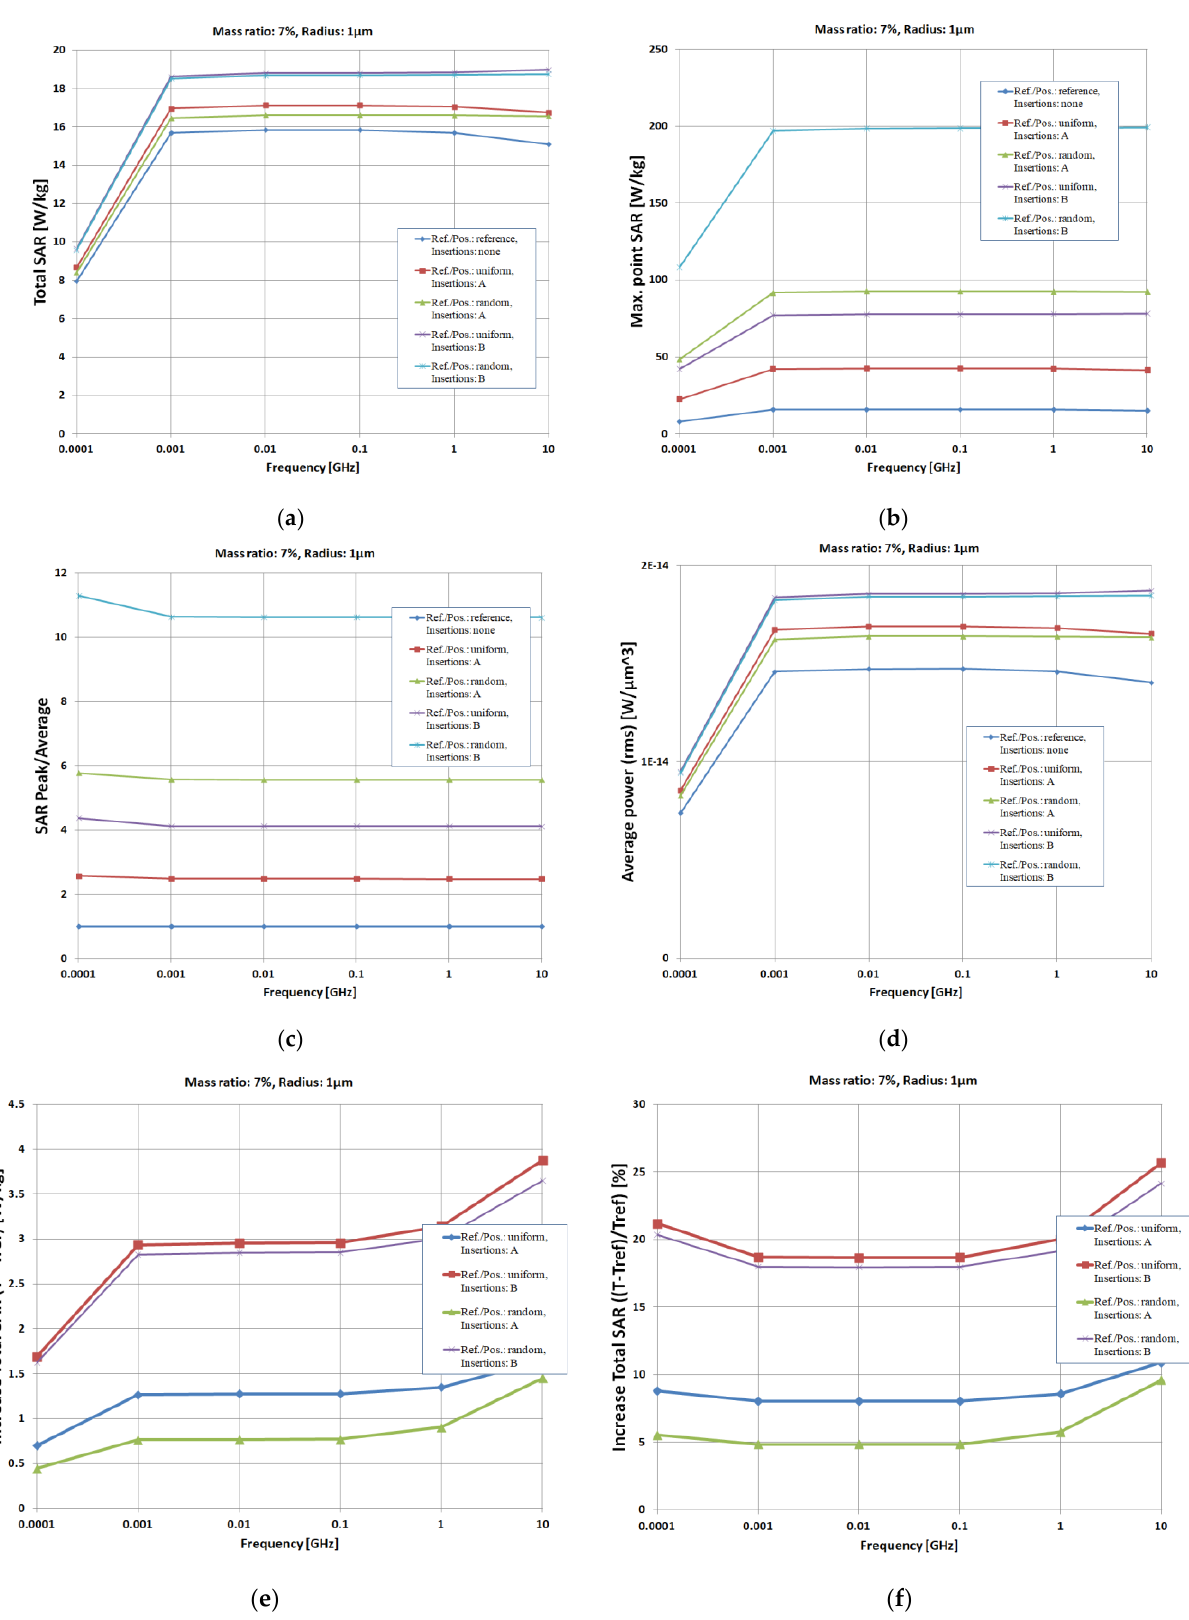
Figure 8. Simulated effect of insertions (type/positioning), MR = 7%, equivalent radius 1 μm : ( a ) - Total SAR (W/kg); ( b ) – Max. SAR (W/kg): ( c ) – SAR peak; ( d ) – Average power (W/μm 3 ); ( e ) – Increase of Total SAR (W/kg); ( f ) – Relative Increase of Total SAR (%) .